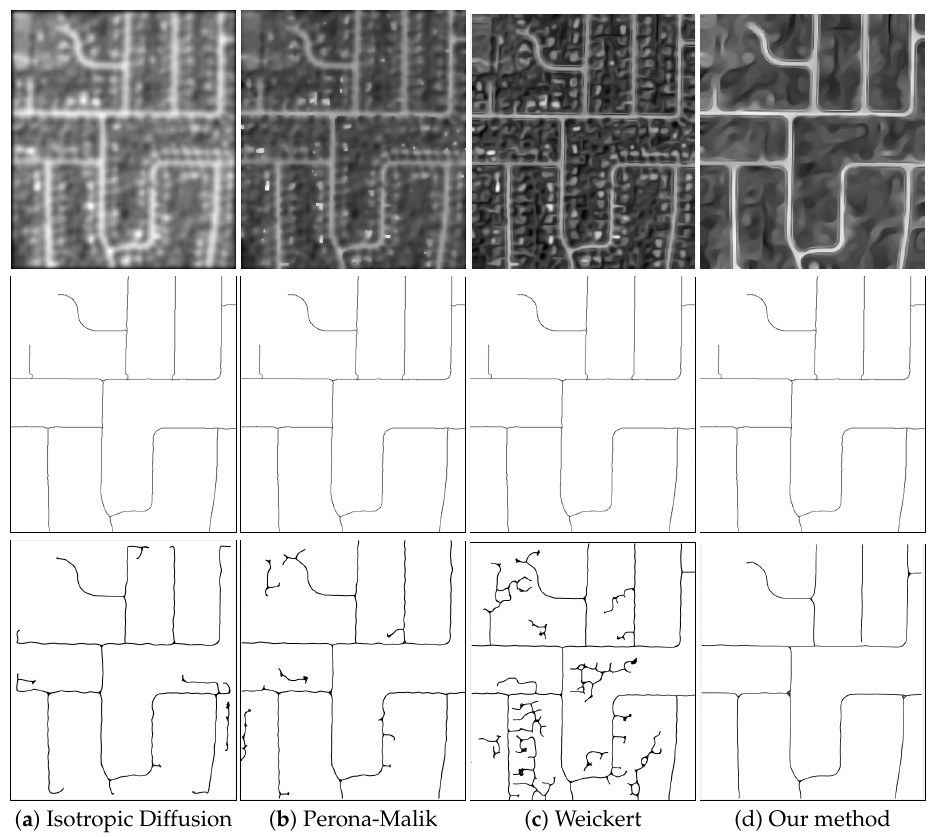
Figure 4. Examples of the detection results for the curvilinear structures in an aerial image using ( a ) isotropic diffusion, ( b ) anisotropic diffusion method proposed by Perona–Malik, ( c ) coherence-enhancing diffusion method proposed by Weickert, and ( d ) recursive anisotropic diffusion using our proposed